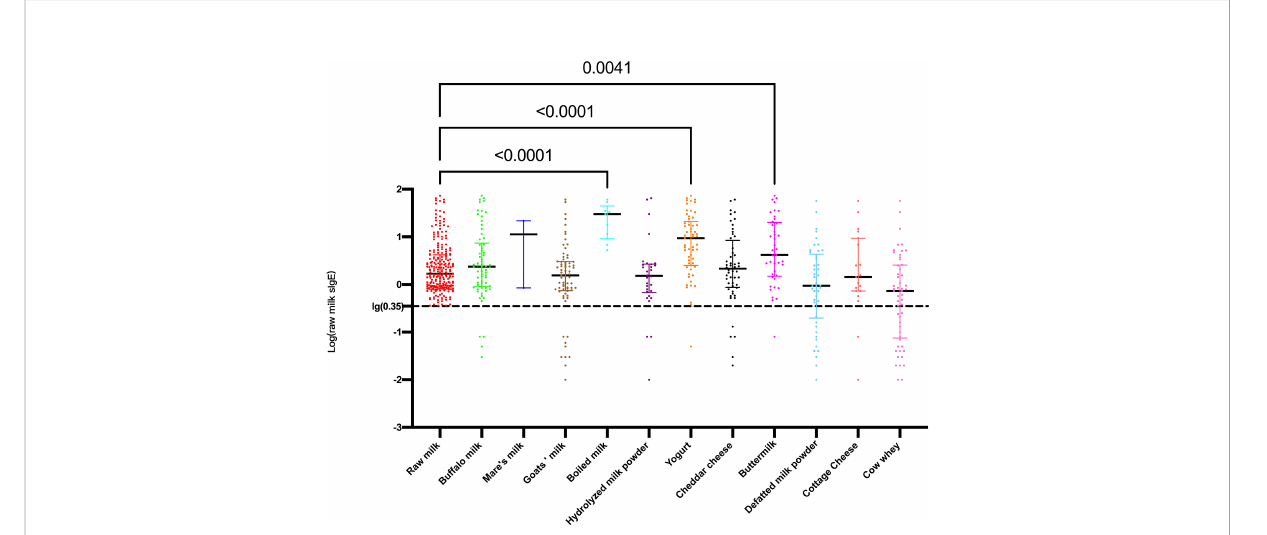
(Figure 4B), a -lactalbumin (Figure 4C) and b -lactoglobulin (Figure 4D). In contrast, the raw milk group observed the lowest levels for raw milk, casein, a -lactalbumin, and b - lactoglobulin. The casein sIgE level in the yogurt and buttermilk groups were lower than those in the boiled milk group ( P <0.0001, Figure 4B).